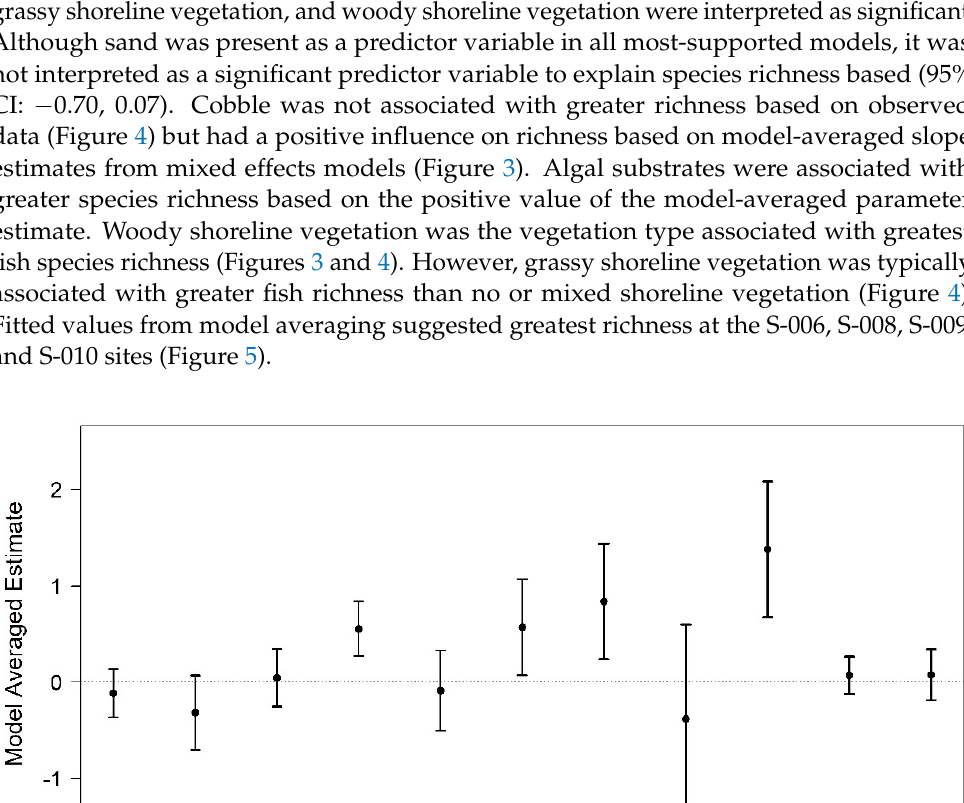
Figure 4. Observed fish species richness from seine hauls in association with habitat variables from the St. Clair and Detroit rivers aggregated across sampling sites and years.